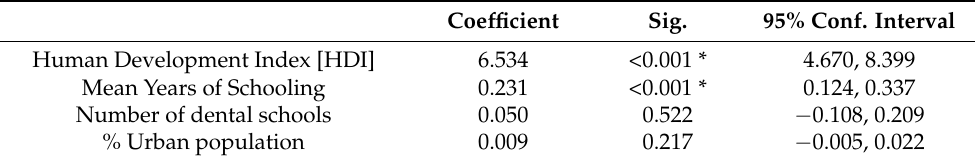
Table 1. Unadjusted linear regression analysis of dentists per 10,000 population in the AFR, 2019. Coefficient Sig.